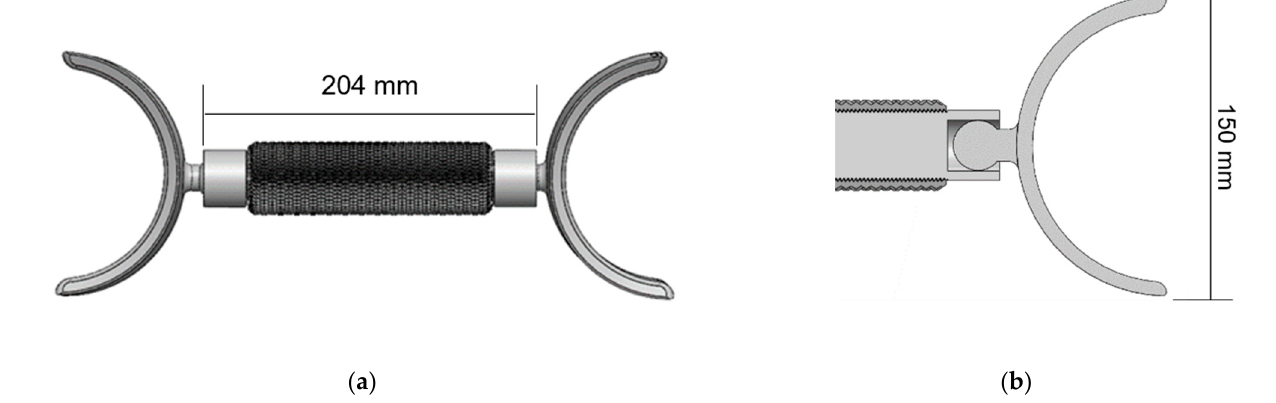
Figure 2. 3D model of the mechanical device: ( a ) Global visualization; ( b ) Detail of pivot system.